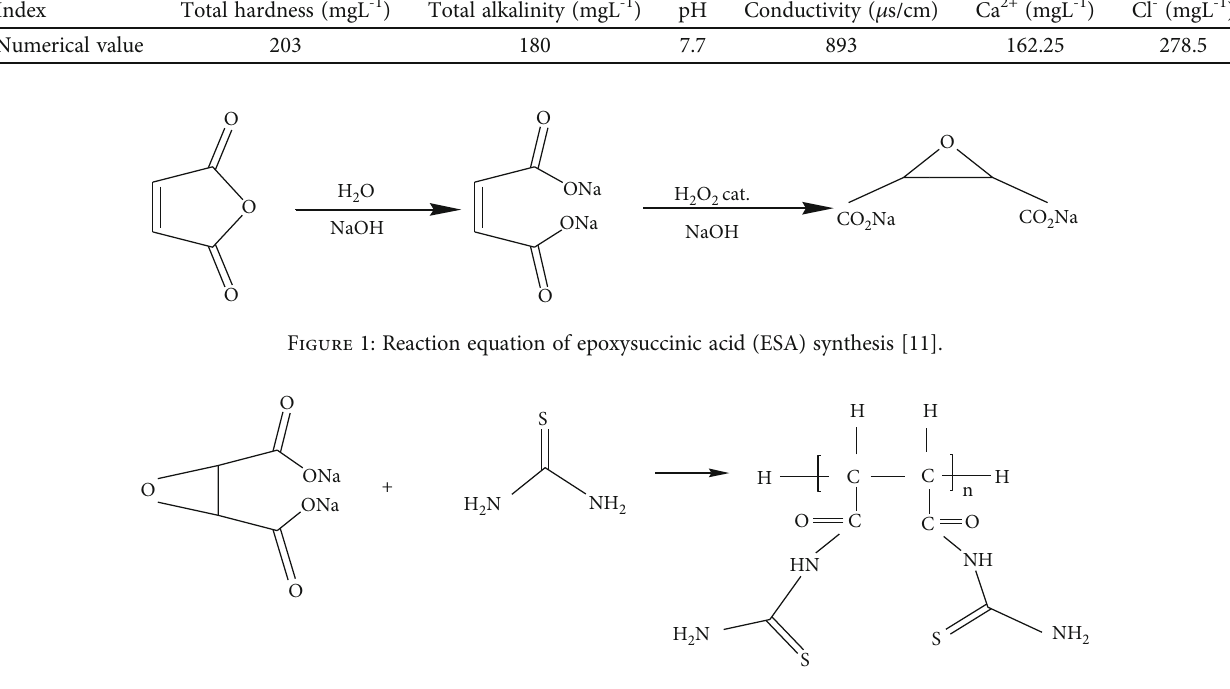
Figure 2: Reaction equation of modi fi ed polyepoxysuccinic acid (CNS-PESA) synthesis